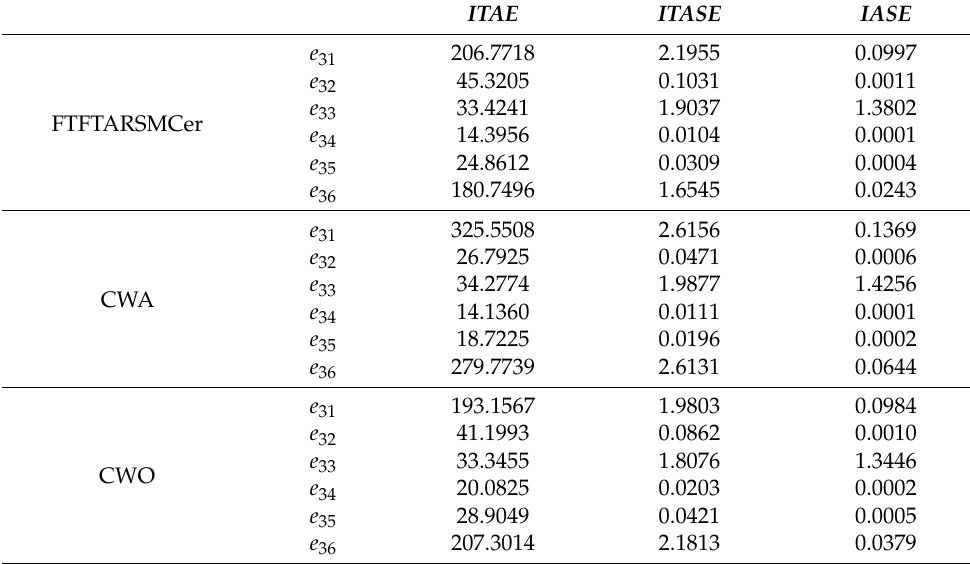
Table 3. Comparison